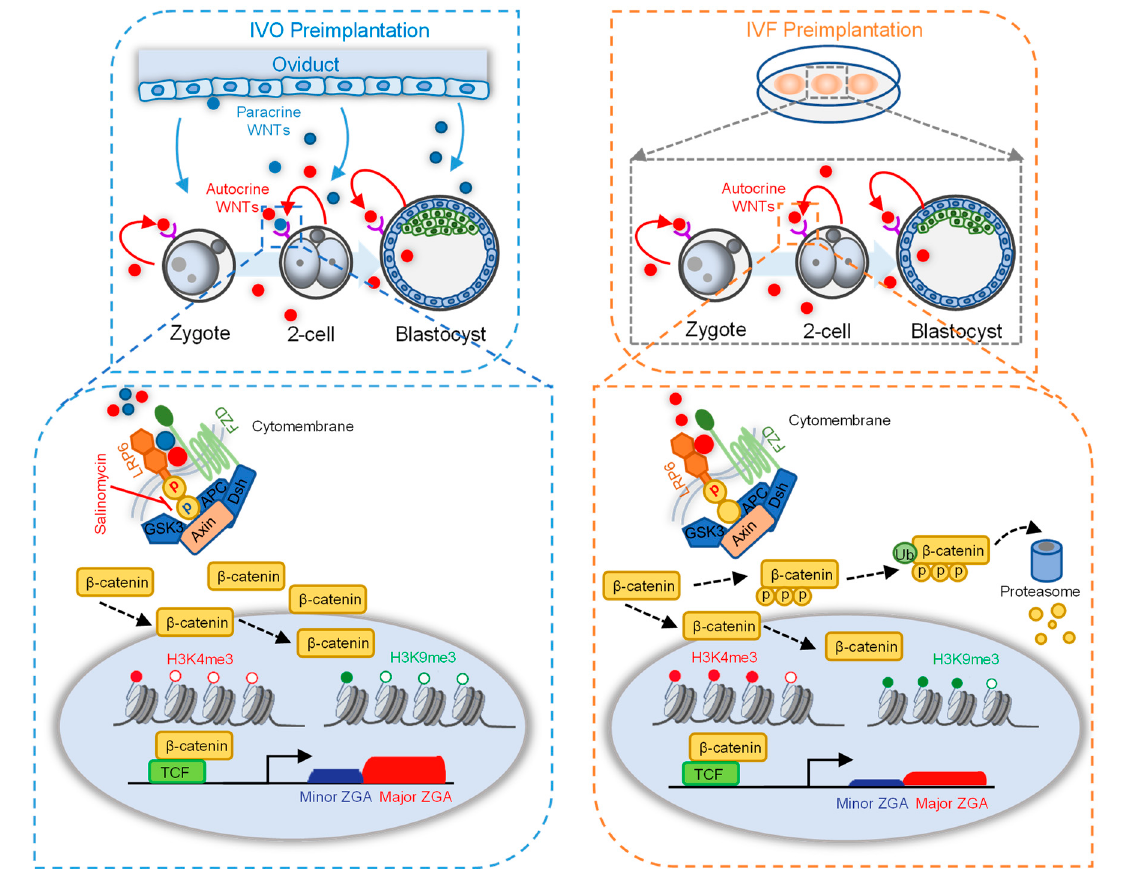
Figure 5. A model illustrating the important roles of LRP6 and paracrine ligands in preimplantation development. The absence of paracrine ligands from the oviduct/uterus in in vitro culture medium impaired embryo developmental potential with aberrant high levels of H3K4me3 and H3K9me3 modi fi cation at the ZGA period. Activation of LRP6 through oviductal and embryonic WNTs promotes in vivo ZGA by a ff ecting H3K4me3 and H3K9me3 reprogramming ( left panel ). The inactivation of LRP6 in the absence of paracrine WNTs from the oviduct/uterus in vitro culture medium impaired ZGA accompanied with aberrant high levels of H3K4me3 and H3K9me3 modi fi cation ( right panel ).